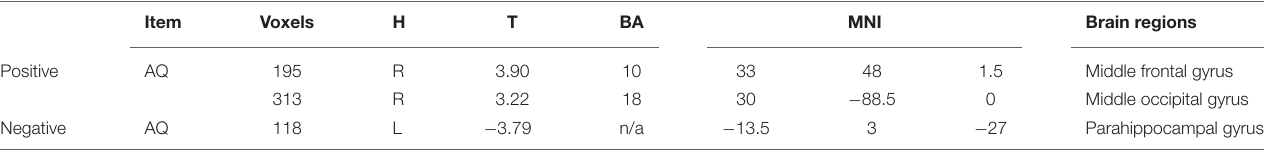
TABLE 2 | The brain regions in gray matter volume significantly correlated with Autism Spectrum Quotient.